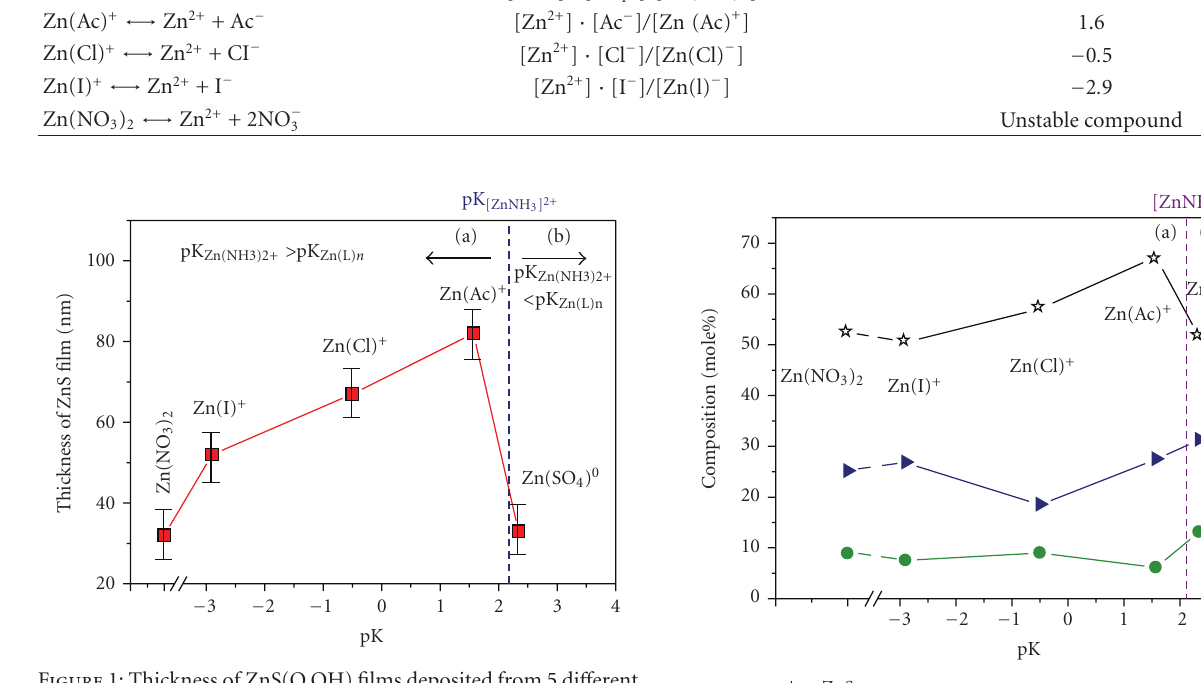
Figure 1: Thickness of ZnS(O,OH) films deposited from 5 di ff erent Zn sources versus pK (instability constant). The blue dashed line indicates Zn[NH 3 ] 2+ complex line, which divides the graph into and (b) pK two regions where (a) pK > pK < Zn(NH3)2+ Zn(L) n Zn(NH3)2+ . Figure 2: The composition of ZnS(O,OH) films versus pK (instabil- pK Zn(L) n ity constant) of Zn complexes. The films contain mainly ZnS (stars), ZnO (circles), and Zn(OH) 2